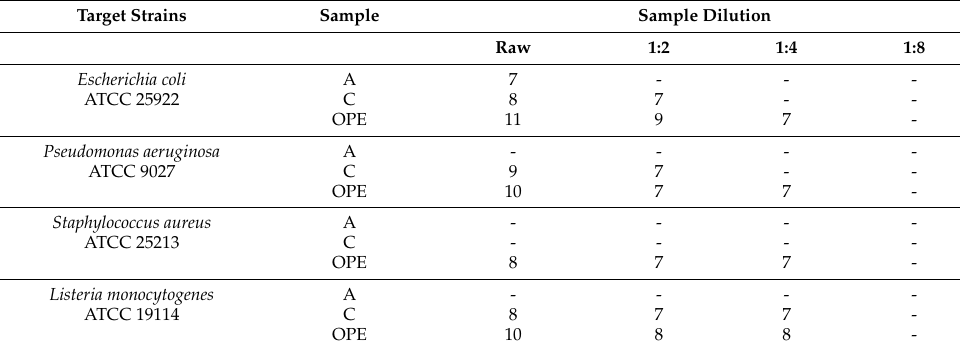
Table 4. Antimicrobial activity (expressed as halo diameter of inhibition in